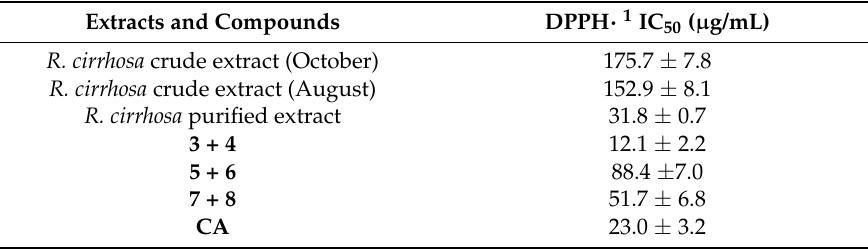
Table 1. IC 50 values of extract of Ruppia cirrhosa and isolated compounds from R. cirrhosa . Extracts and Compounds